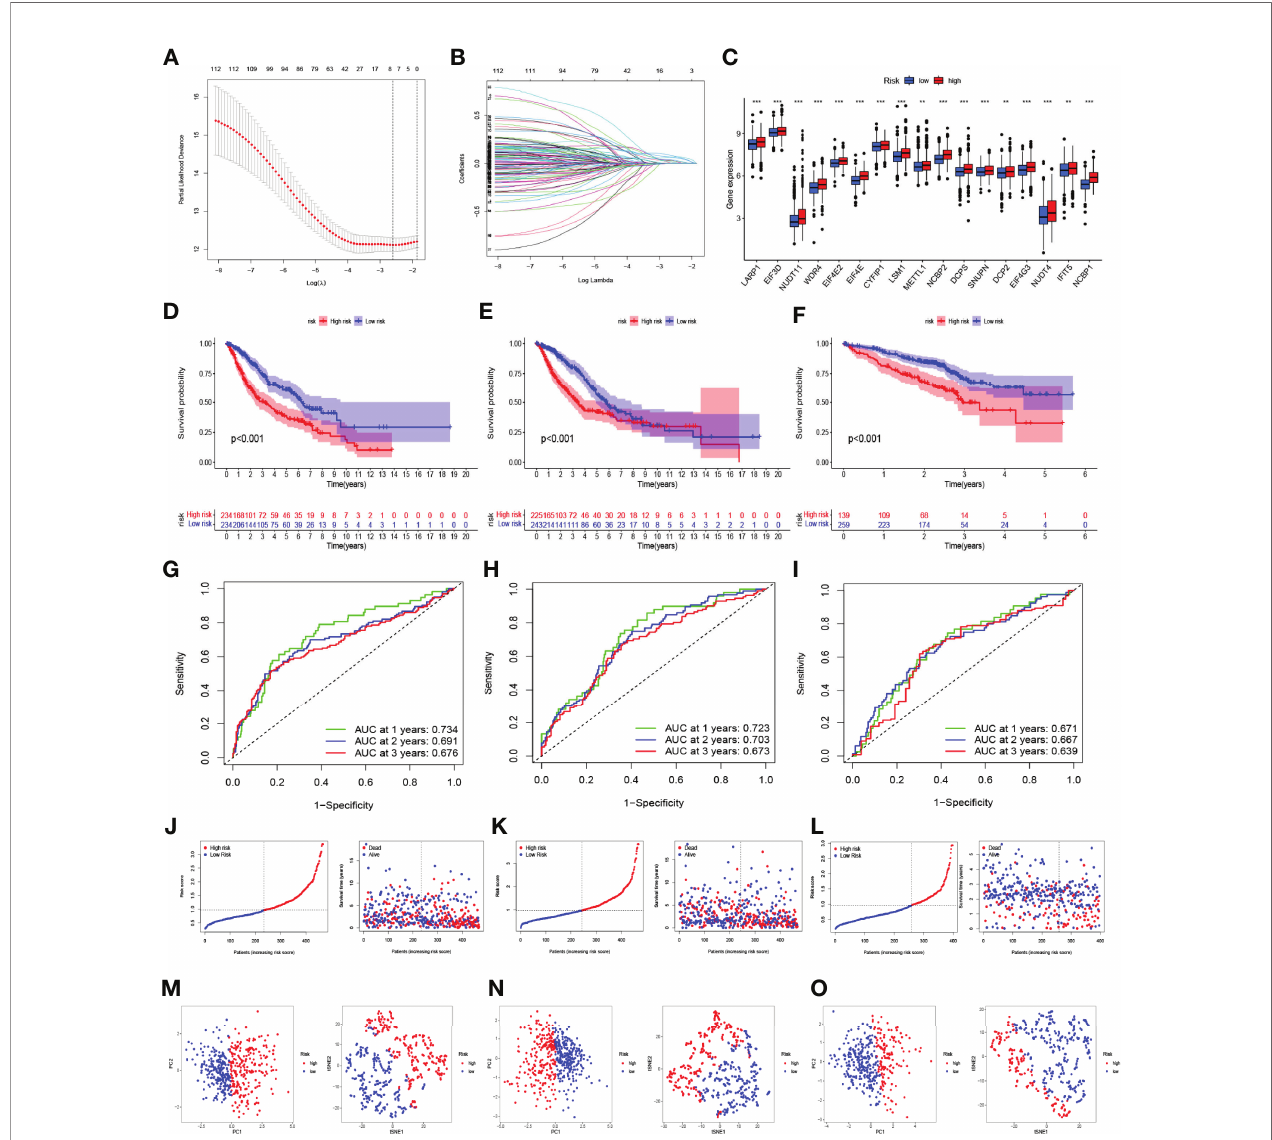
FIGURE 5 | Construction and validation of the prognostic model based on the m 7 G-related gene signatures in lung adenocarcinoma (LUAD). (A, B) LASSO analysis with minimal lambda value. (C) The difference in the expression of m 7 G-related genes in the high- and low-risk groups. The Kaplan – Meier survival analysis showing the difference in overall survival (OS) between the high- and low-risk groups in the training (D) , internal validation (E) , and external validation cohorts (F) . Time- dependent ROC curve analysis in the training (G) , internal validation (H) , and external validation cohorts (I) . The distribution of risk score and survival status of LUAD patients with different risk scores in the training (J) , internal validation (K) , and external validation cohorts (L) . PCA and t-SNE analyses in the training (M) , internal validation (N) , and external validation cohorts (O) . ** p < 0.01, *** p <